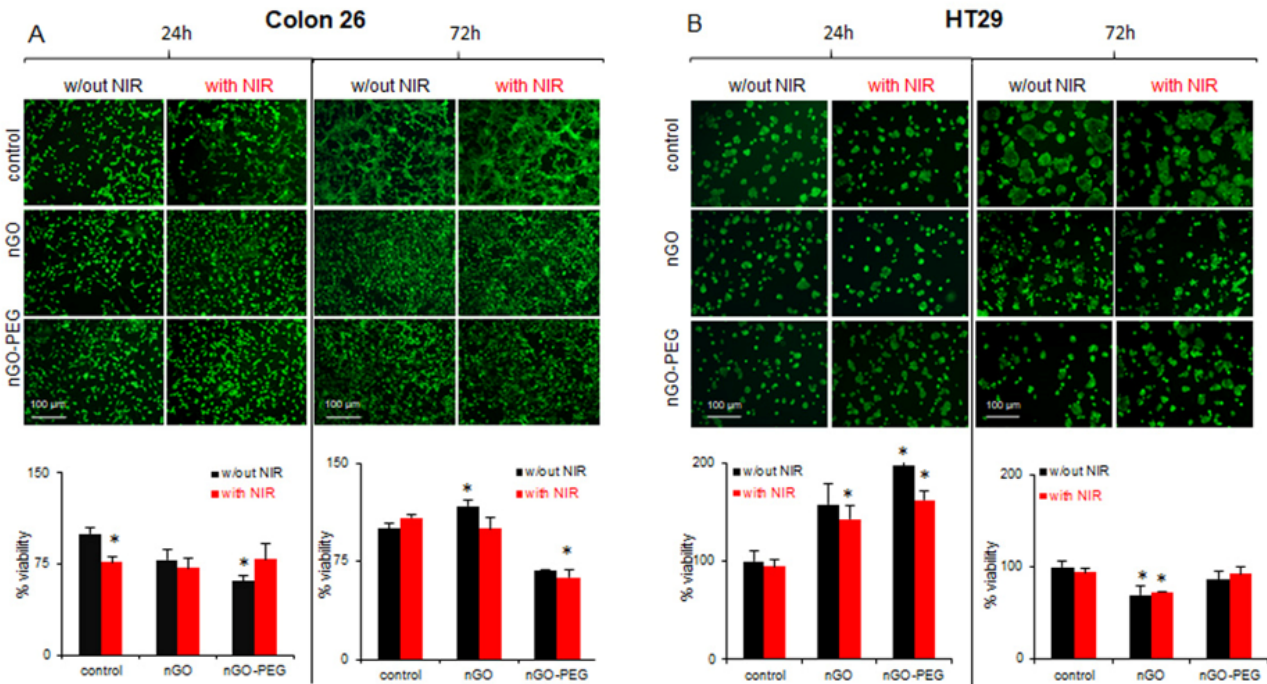
Figure 6. In vitro biological effects of NIR-irradiated nGO and nGO-PEG on low and highly invasive colon cancer cells with and without NIR irradiation. ( A ) FDA staining of Colon26 cells and WST-1 cellular viability assay at 24th and 72nd hour of cultivation with nGO and nGO-PEG. ( B ) FDA staining of HT29 cells and WST-1 cellular viability assay at 24th and 72nd hour of cultivation with the nanoparticles (NPs). Percent viability for the two cell cultures is calculated after three repetitions of the FDA staining and results are MEAN ± STDV. * designates statistical